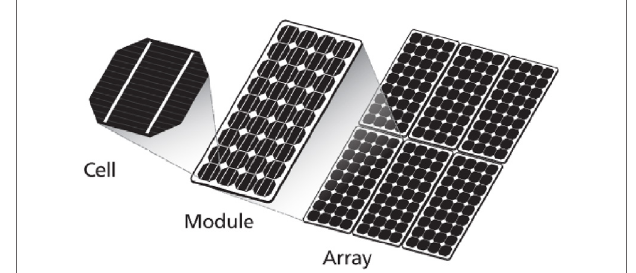
FigUre 6 | Picture of (a) surrette 6cs25Ps (http://www.dcbattery. com) and (B) hoppecke 10 Opzs 1000 (http://www.biotechx.com/)